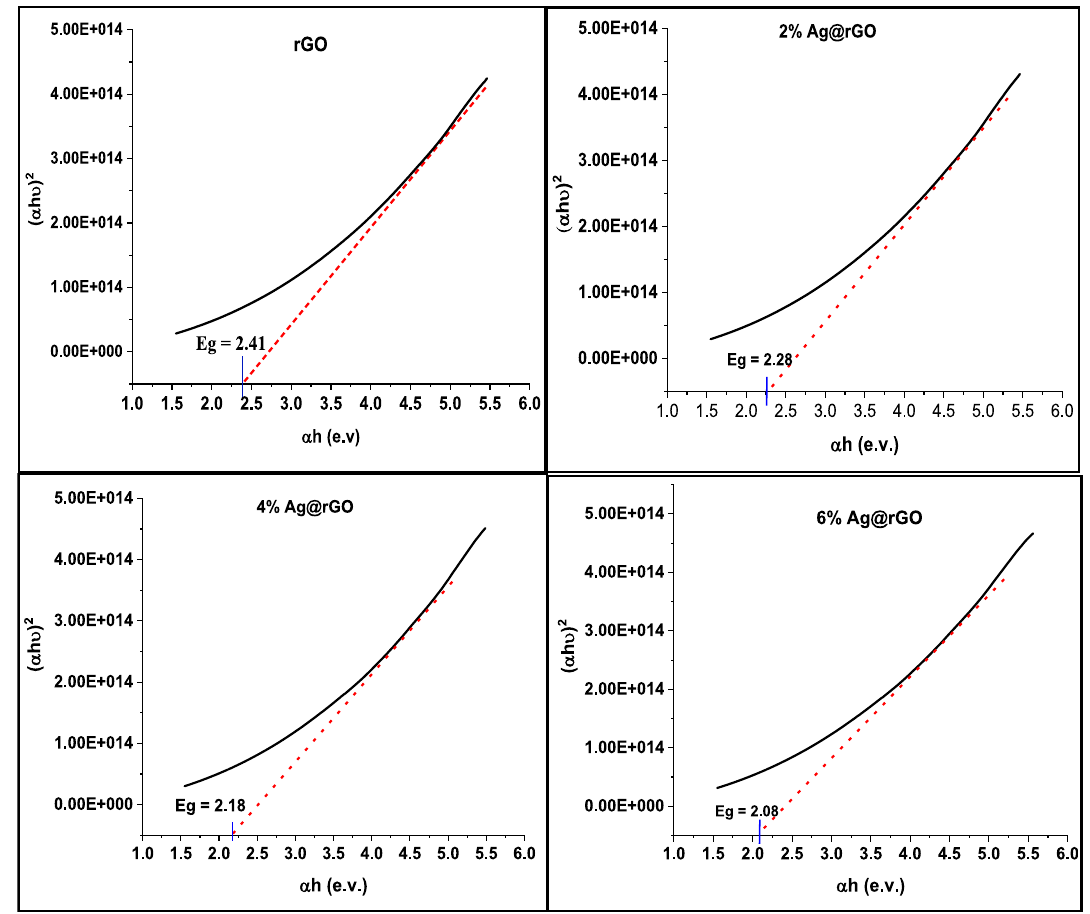
Fig. 2 Tauc’s plot of for estimation the energy band gap (Eg) of the prepared